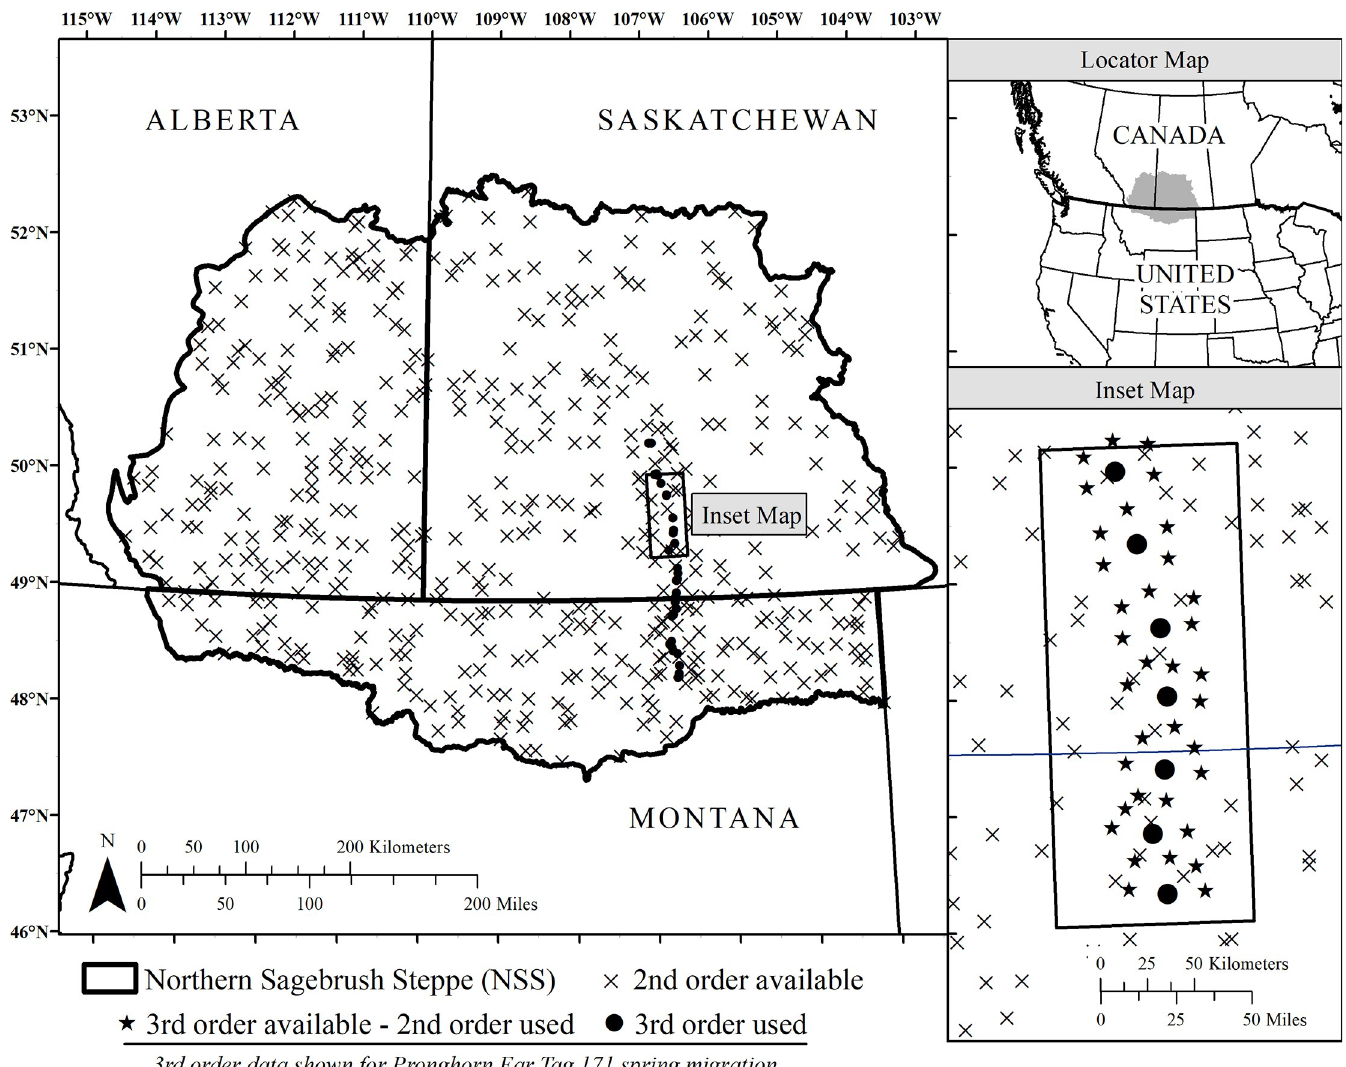
Fig 1. An example of the hierarchically nested used-available design for one individual (Pronghorn Ear Tag 171) to predict pronghorn ( Antilocapra americana ) migratory route habitat selection during spring at two scales across the Northern Sagebrush Steppe. Pronghorn second-order selection compares migratory neighborhoods to the entire study area whereas third-order selection compares migratory pathway relocations to the migratory neighborhood. Scales of migration habitat selection are nested as a result of third-order available locations also operating as used locations at the broader, second-order scale. This original map was created using ArcGIS Desktop version 10.4.1 (ESRI, Inc., Redlands, California, USA) and includes vector data from Natural Earth (“Admin 1 –States, Provinces”) which complies with CC BY 4.0 license; available from https://protect-us.mimecast.com/s/pxvaCxkVBDILmvE2uAfAL2?domain=naturalearthdata.com.